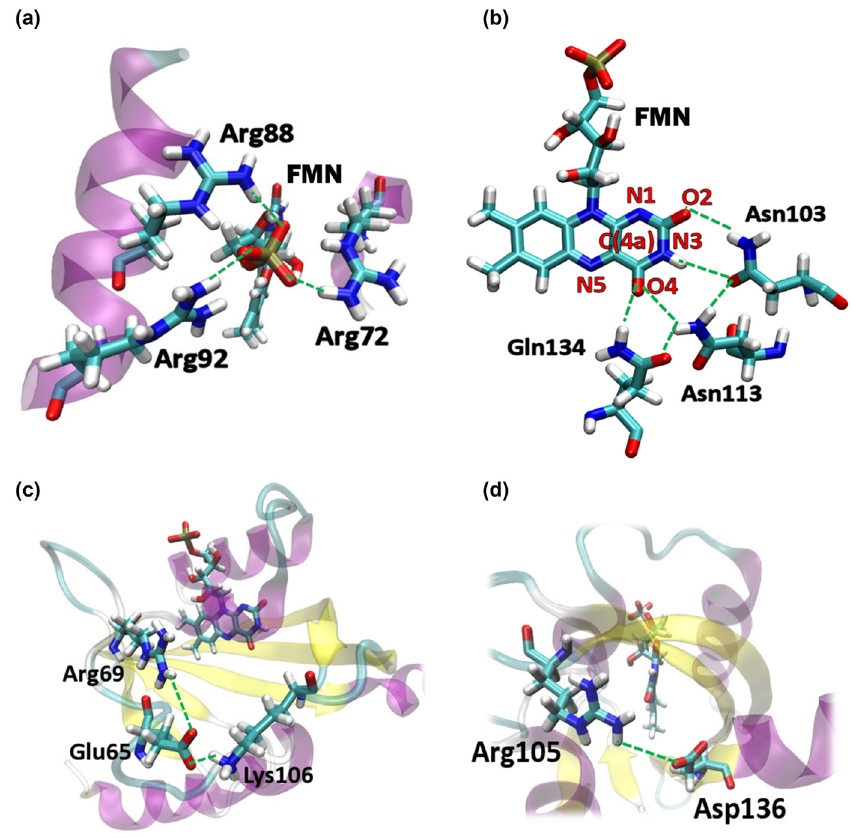
Figure 3: Key structural features of LOV domain in Mr 4511. ( a ) The three arginine residues interacting with FMN phosphate group. ( b ) The residues triad establishing an H - bond network with FMN. ( c ) and ( d ) The two conserved salt bridges lining the doorways to the binding